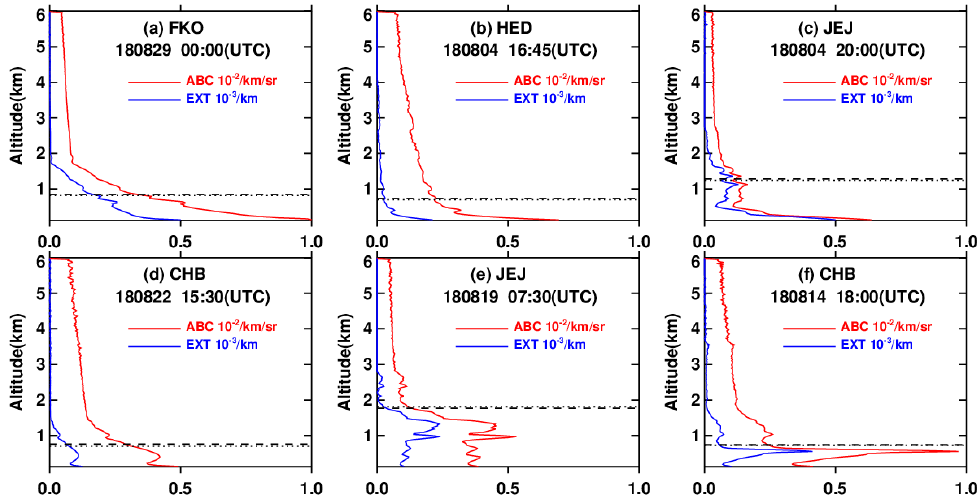
Figure 2. Profile of the attenuated backscatter coefficient (ABC) at 532 nm and extinction coefficient profiles (EXT) using the Fernald inversion on ( a ) 29 August 2018 at the site of FKO, ( b ) 4 August 2018 at the site of HED, ( c ) 4 August 2018 at the site of JEJ, ( d ) 22 August 2018 at the site of CHB, ( e ) 19 August 2018 at the site of JEJ and ( f ) 14 August 2018 at the site of CHB. The BLH from CALIPSO and Lidar is shown in dotted line and dashed line, respectively. The vertical and time resolution is 30 m and 15 min, respectively.